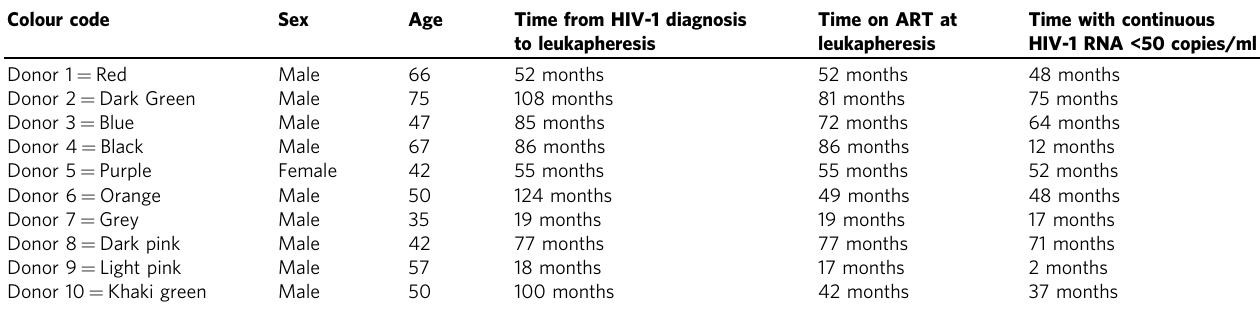
Table 3 Characteristics of PLWHIV donors used in this